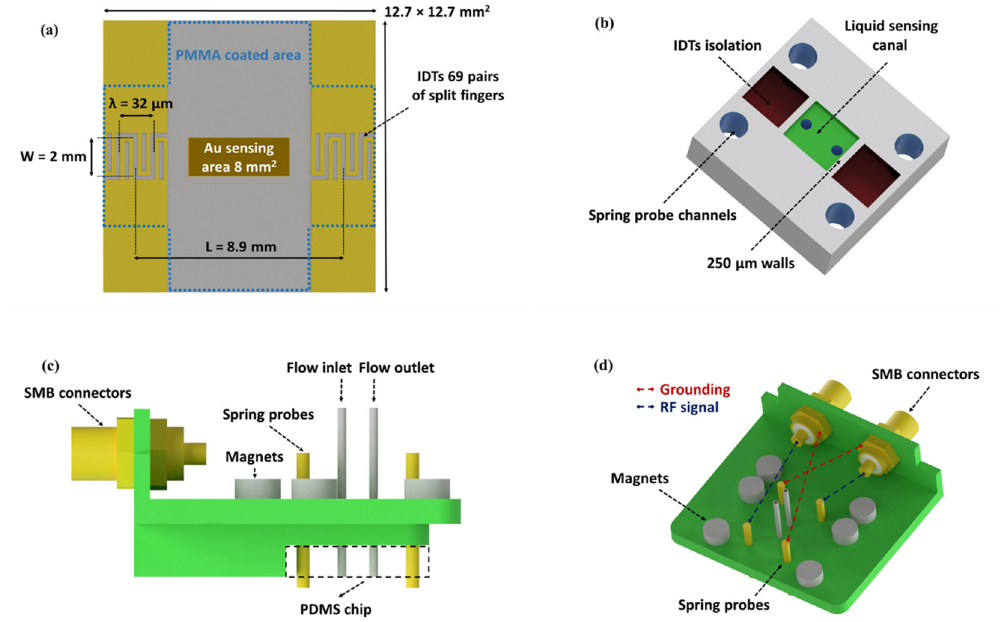
Figure 2. ( a ) SPR / LW-SAW sensor device; ( b ) PDMS microfluidic chip; ( c ) 3D-printed holder (side view); and ( d ) 3D-printed holder (top view).